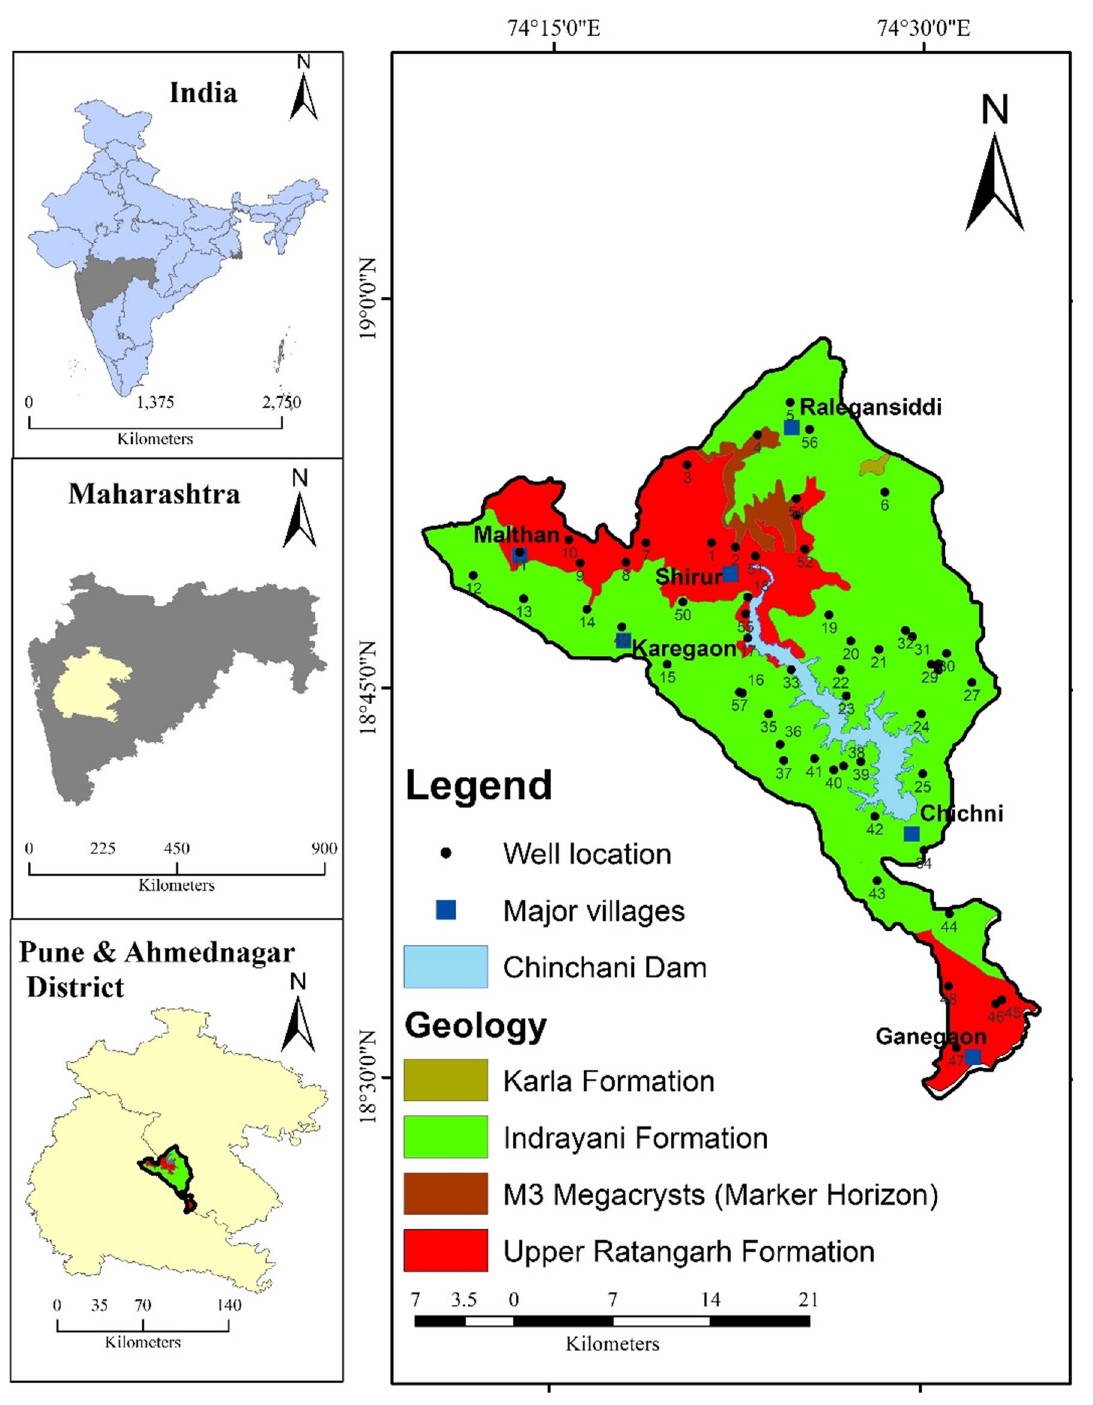
Fig. 1 Study area: Upper Bhima